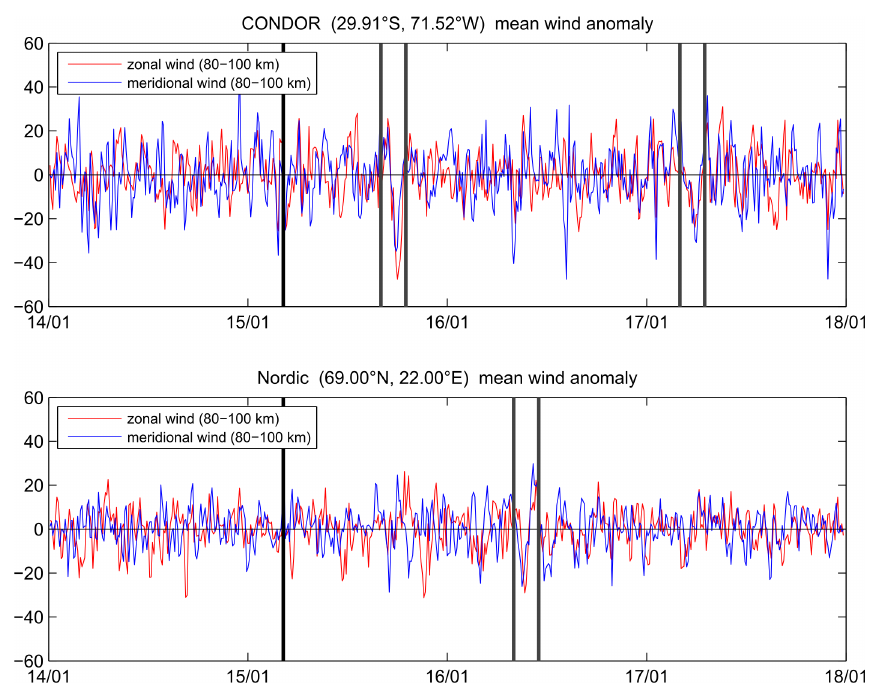
Figure 4. Zonal and meridional wind anomalies for two 30 × 30km grid cells centered at the geographic coordinates of CONDOR (29.91 ◦ S, 71.52 ◦ W) and the Nordic Meteor Radar Network (69.0 ◦ N, 22.0 ◦ E), respectively, both averaged between 80–100km altitude after removing a 4h running mean. The vertical lines are explained in the caption of Fig. 2.